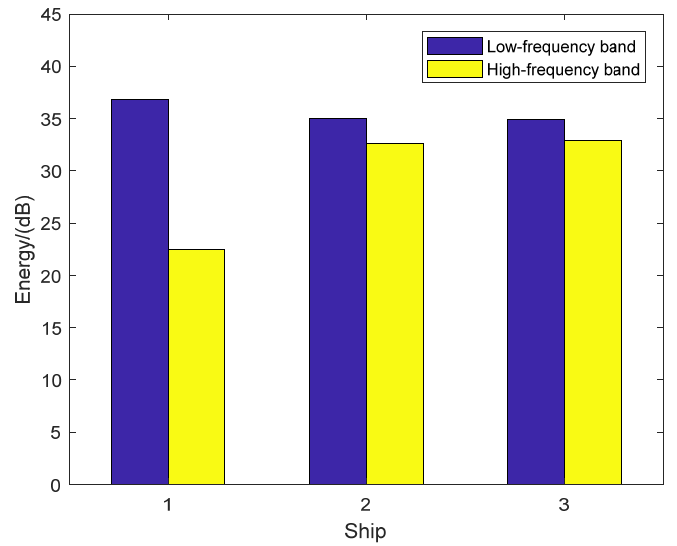
Figure 3. CEEMNAN results for S-RN signals.